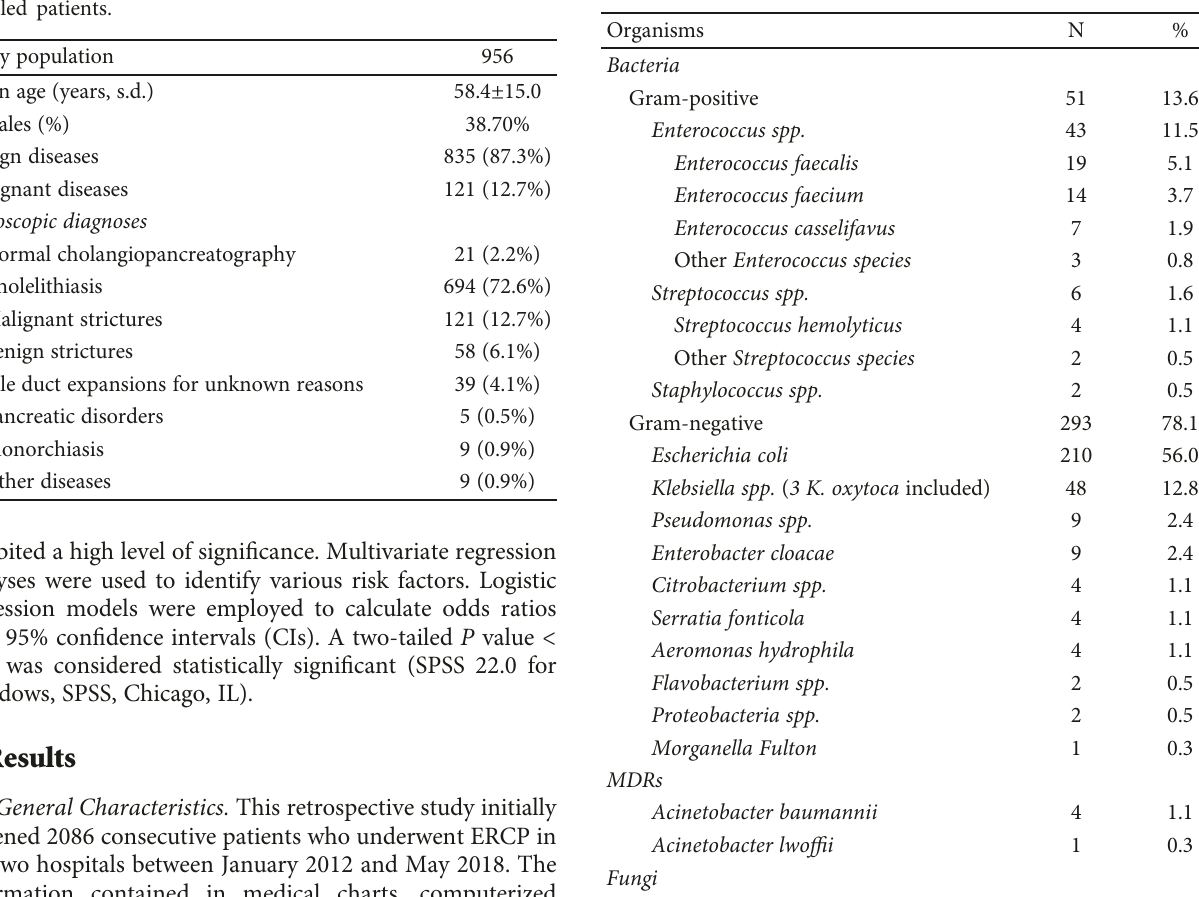
Table 2: Microbiological classi fi cation of positive bile